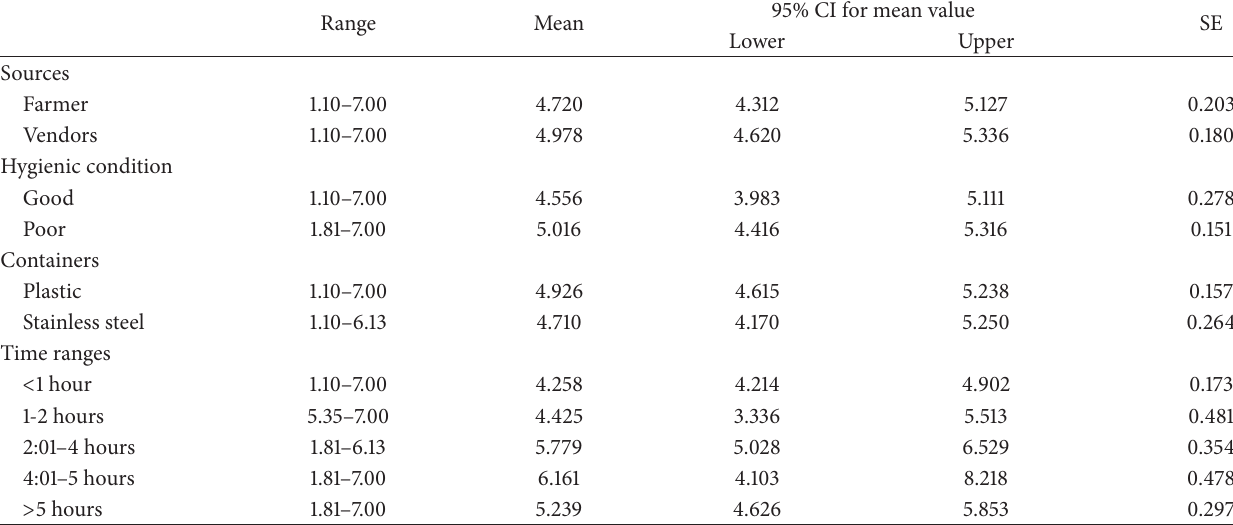
95% CI for mean value